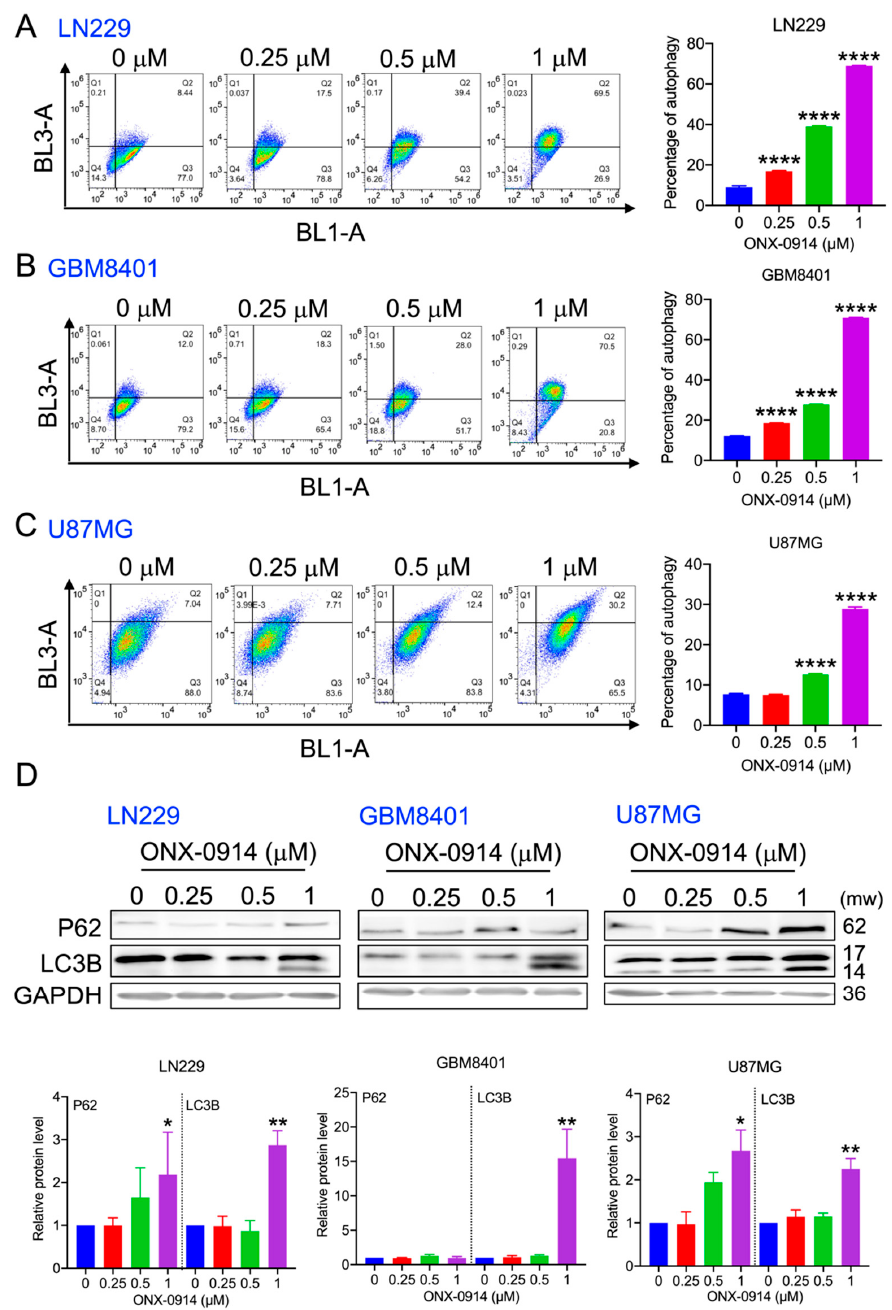
Figure 5. The effect of ONX-0914 on autophagy. The cells were stained with acridine orange for 10 min in the incubator. The percentage of autophagic ( A ) LN229, ( B ) GBM8401, and ( C ) U87MG cells is shown. The right panel shows the quantification. ( D ) The autophagy-related proteins P62 and LC3B were evaluated using Western blotting. GAPDH was used as a loading control. *, p < 0.05; **, p < 0.01; ****, p < 0.0001 compared to the control group. Moreover, autophagy-related protein expression in glioblastoma cell lines was ana- lyzed by Western blotting. p62 was increased by 1 mM ONX-0914 in LN229 and U87MG cells compared to that in the control group (Figure 5D). In addition, LC3B-II was increased 2.8-, 15.4-, and 2.2-fold in LN229, GBM8401, and U87MG cells, respectively, compared to